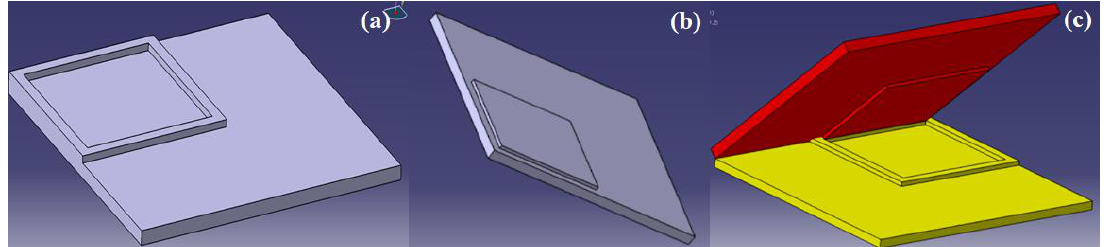
Figure 2. ( a ) Lower mold half, ( b ) upper mold half, and ( c ) open mold.